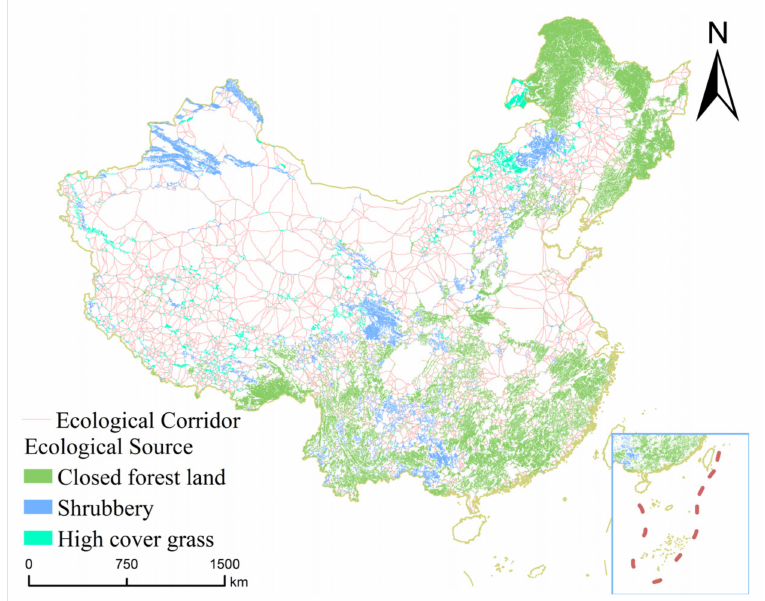
Figure 6. Ecospatial network of the Study